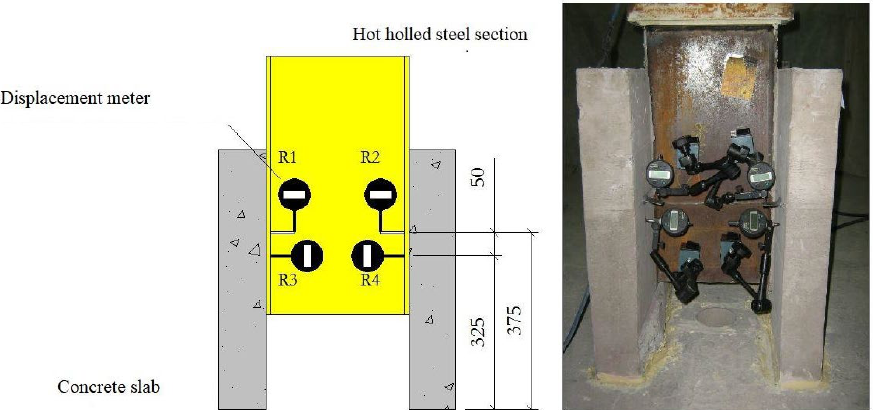
Figure 6. Positioning of displacement meters.